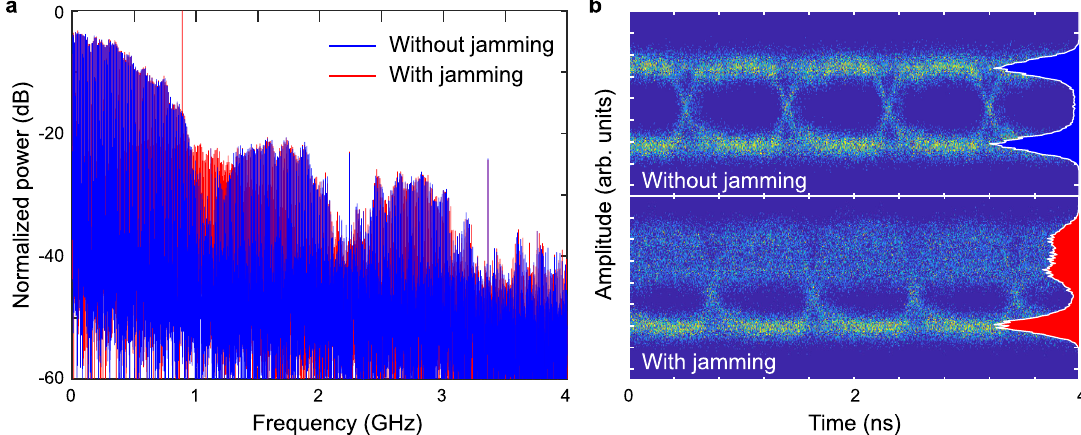
Fig. 2 Effect of jamming. a Spectra and b eye diagrams measured by Bob, with and without the effect of jamming. In this example, the detuning Δ ν is 0.89 GHz, and Mallory broadcasts 10.7 dBm into Bob ’ s antenna side lobe, relative to Alice transmitted power of − 10.5 dBm into the main antenna lobe. Mallory ’ s jamming introduces a wide interference component in the spectrum. In the time domain, the jamming asymmetrically affects the high bit as can be seen by comparing the histograms of data point distribution on the unjammed (top) and jammed (bottom) eye